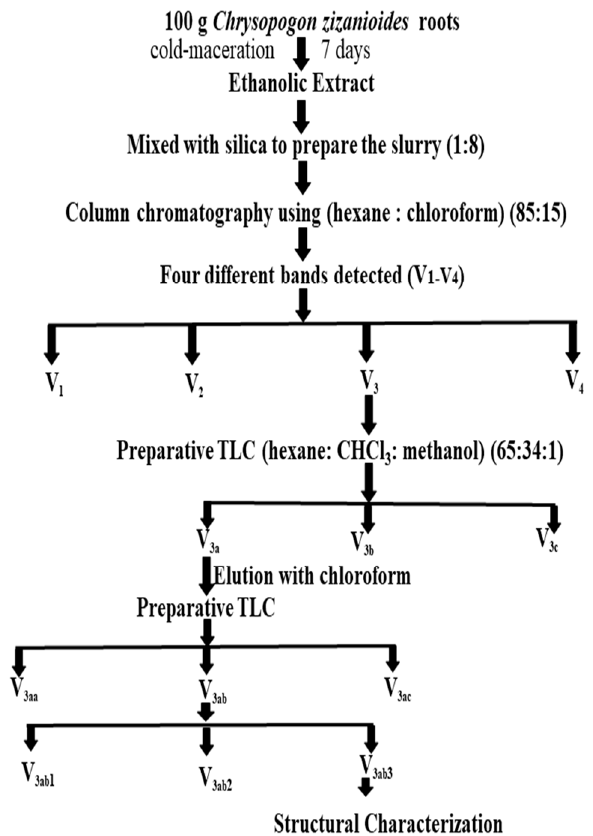
Figure 6. Isolation of compound ‘X’ from C. zizanioides.